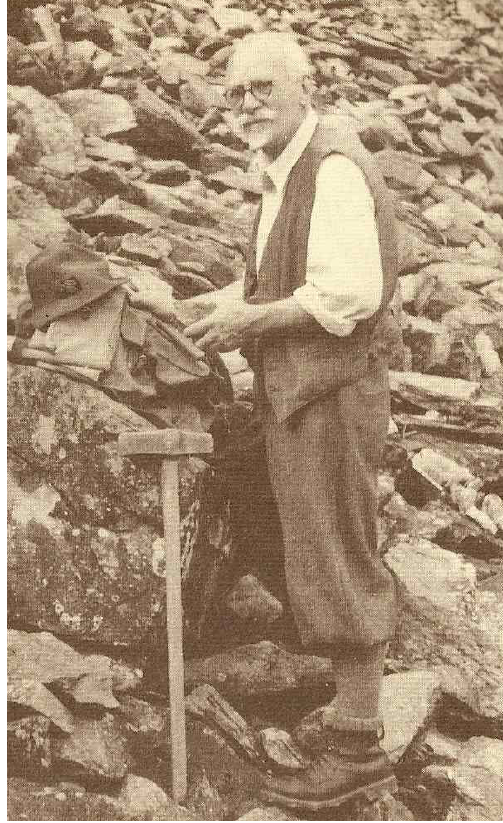
Figure 1. Pietro Sigismund collecting at Valmalenco. Figure repro- duced with permission from the Ecomuseo della